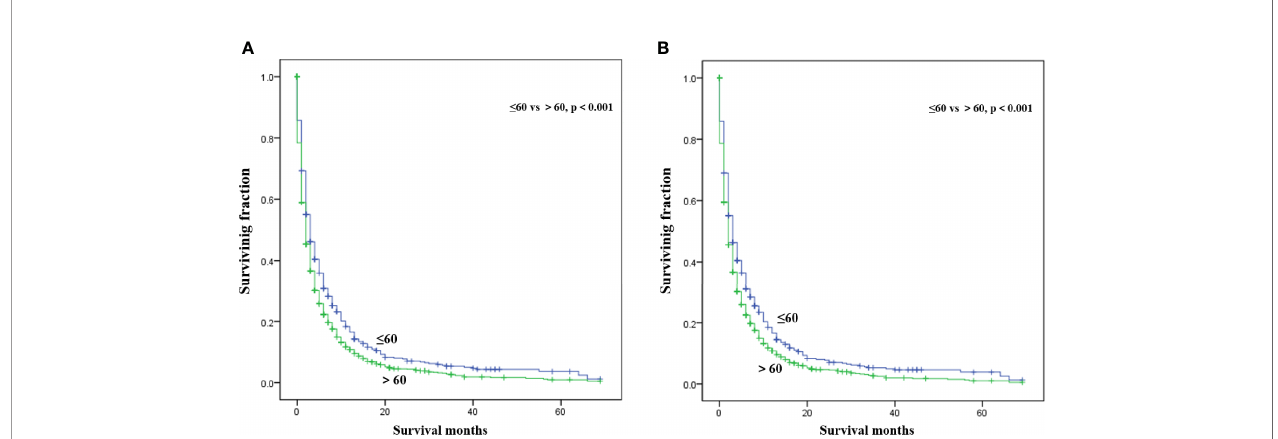
FIGURE 3 | Kaplan-Meier survival curves for estimating OS (A) and CSS (B) in patients with PCBM based on age.